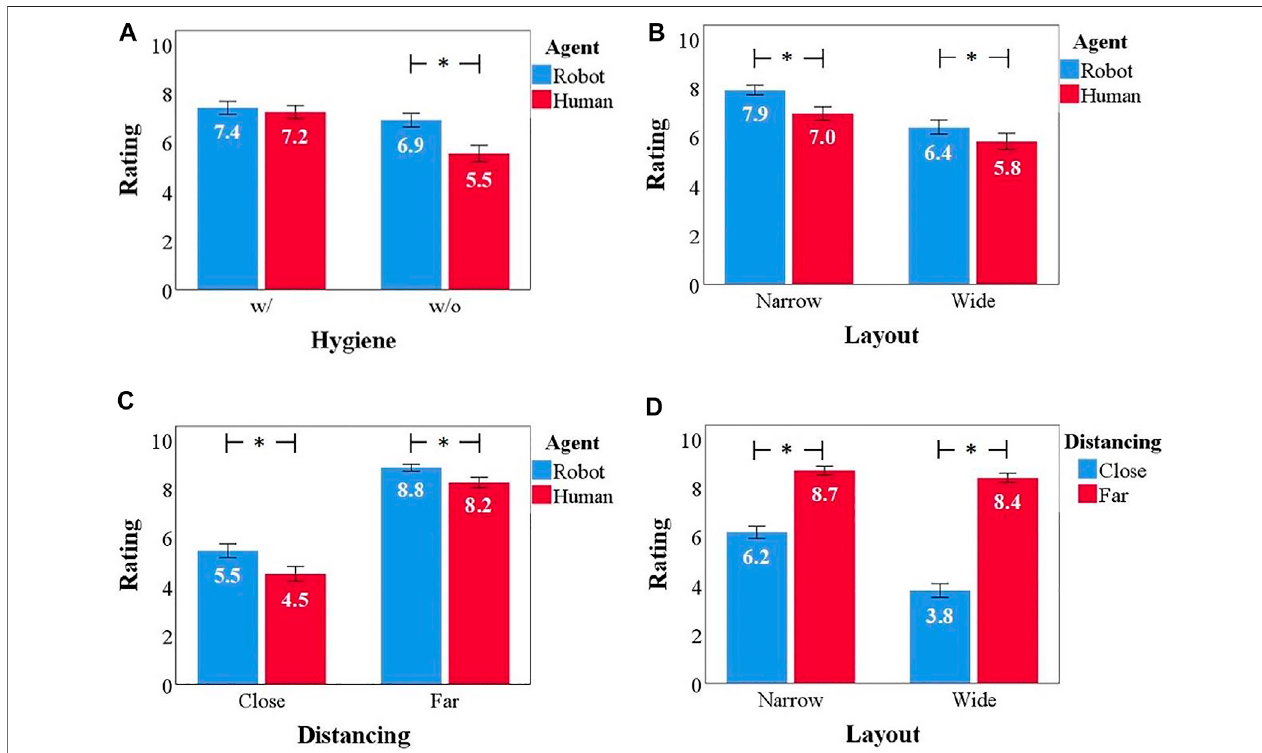
FIGURE 4 | Summary of interaction effects between agent * hygiene (A) , agent * layout (B) , agent * distancing (C) , and layout * distancing (D) . The star symbol indicates a signi fi cant difference between pairs. Mean values of the subjective rating are represented by the bars and the numbers on it. The error bars show the con fi dence